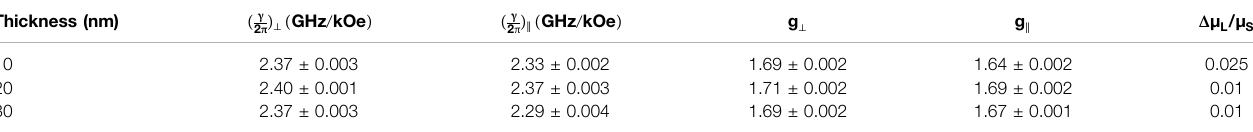
TABLE 2 | Gyromagnetic ratio and Landé g-factor under in-plane and out-of-plane magnetized condition of the TmBiIG fi lm with various thicknesses. Thickness